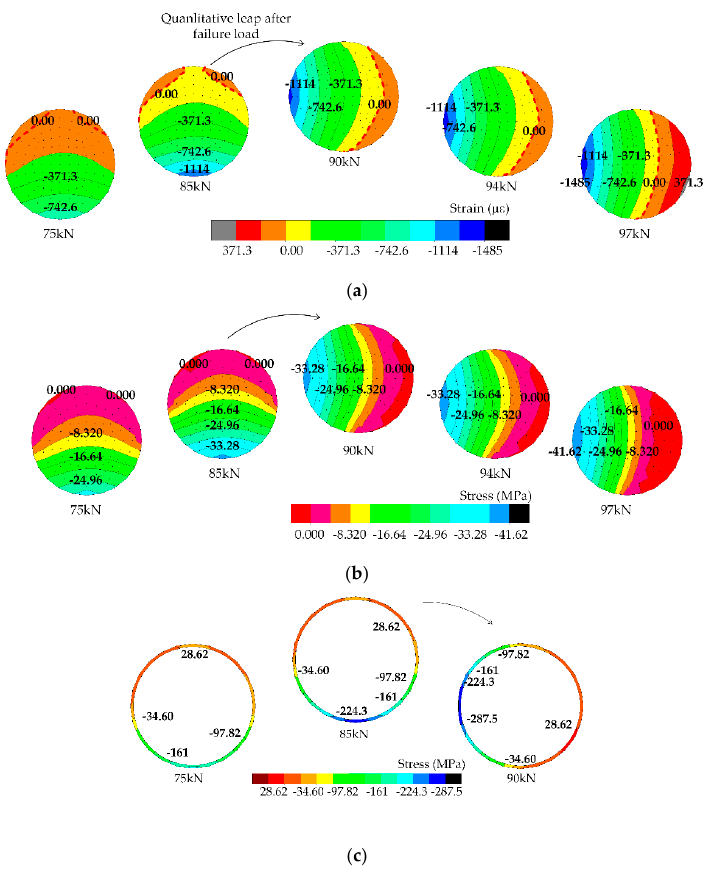
Figure 9. The contour maps of strain/stress fields on Section 2: ( a ) the strain fields; ( b ) the stress fields of core concrete; ( c ) the stress field of steel tube.